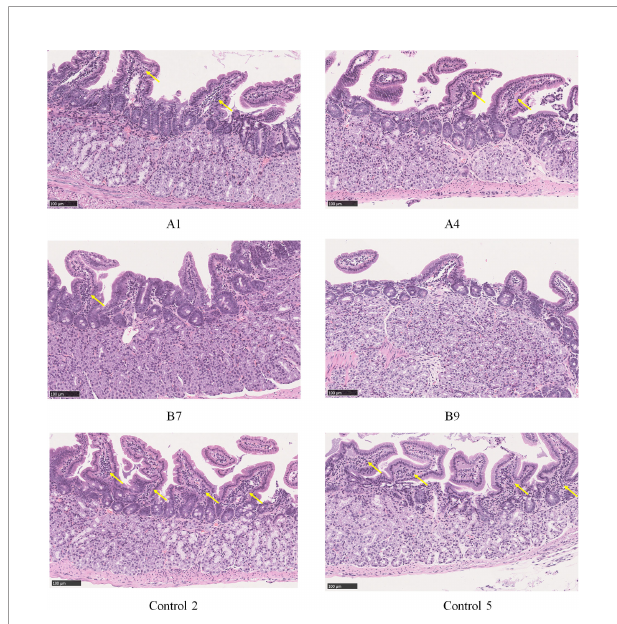
FIGURE 5 | Histopathological pictures of gastric antrum mucosa in some experimental mice (HE staining). Group A: a small amount of lymphocyte in fi ltration and mild in fl ammation in the gastric antrum mucosa of mice A1 and A4; Group B: a small amount of lymphocyte in fi ltration and mild in fl ammation in the gastric antrum mucosa of mouse B7, and no obvious abnormality in mouse B9; Control group: moderate lymphocyte in fi ltration and moderate in fl ammation were seen in the lamina propria of gastric antrum mucosa of mice 2 and 5 in the control group. Locations of lymphocyte aggregation were indicated by yellow